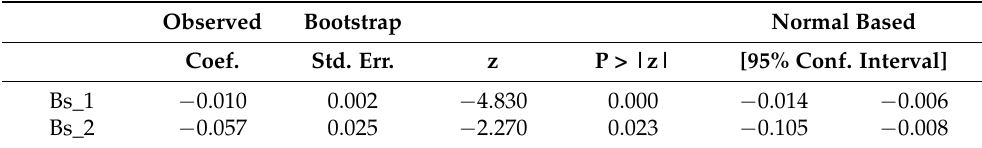
Table 9. Bootstrap test of the mediating effect of business